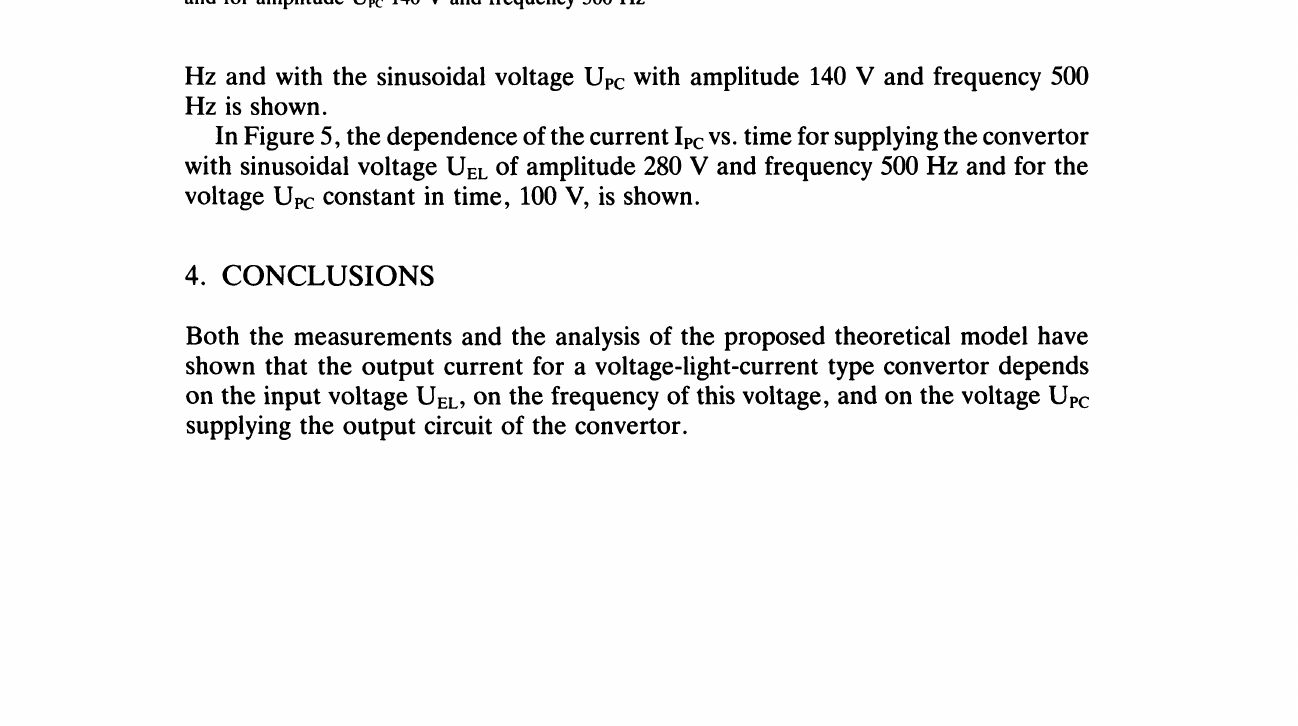
FIGURE 4 Dependence of the current Ipc on time for amplitude UEL 280 V and frequency 500 Hz and for amplitude Upc 140 V and frequency 500